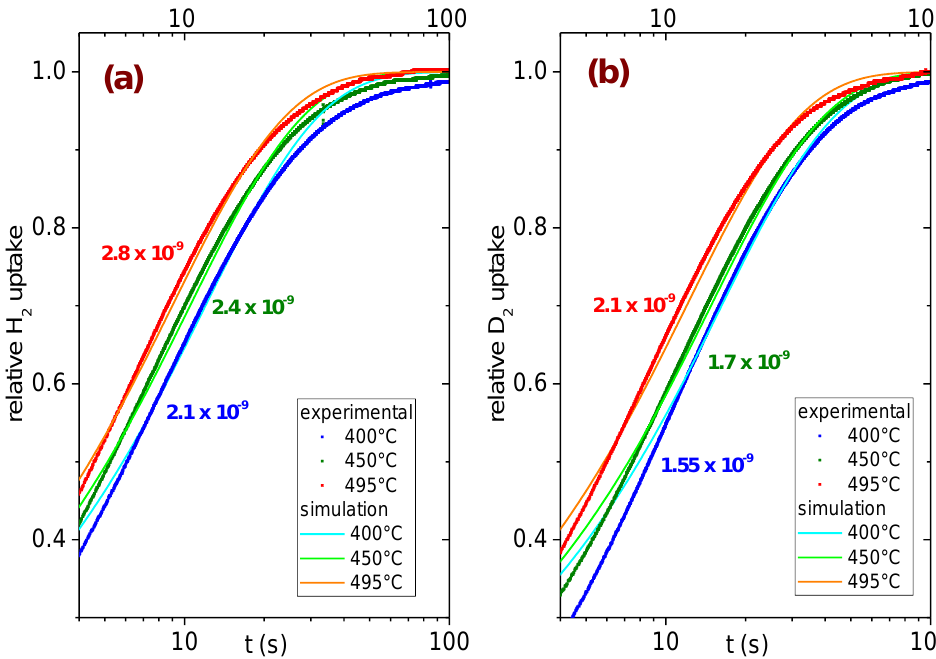
Figure 4. Time dependence of the relative absorption of hydrogen (panel ( a )) or deuterium (panel ( b )) at selected temperatures and best fit lines. The colored numbers are the derived coefficient of diffusion in m 2